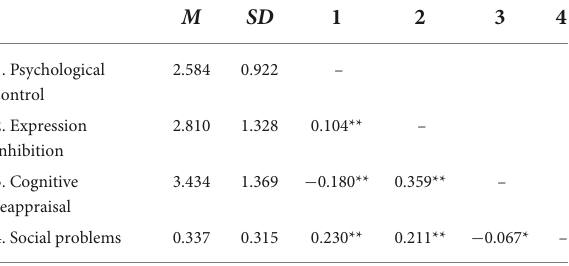
TABLE 1 Pearson correlation coefficients of the study variables ( N =